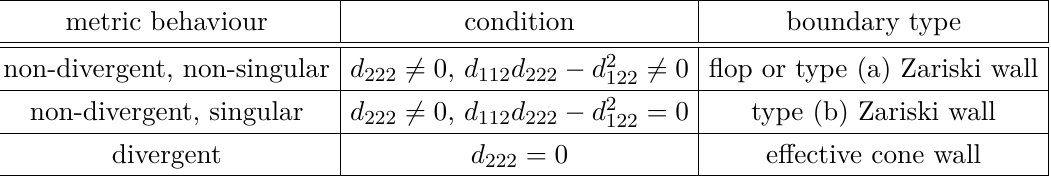
Table 2 . Relation between metric behaviour at x = 0 and the type of Kähler cone